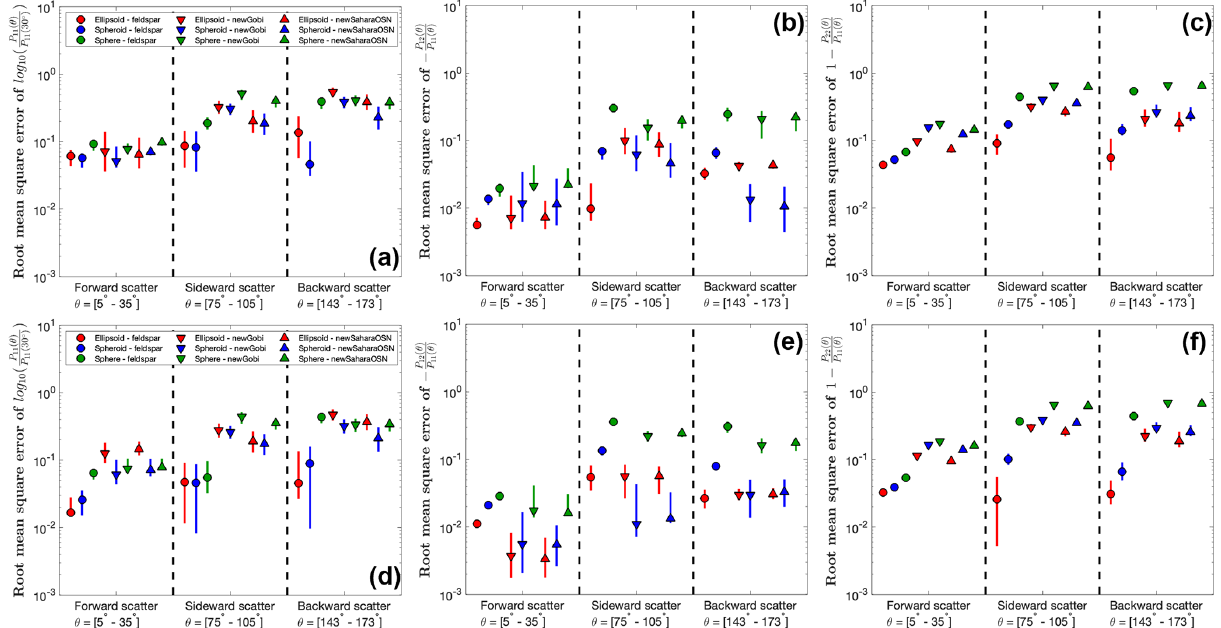
Figure 6. Root mean square errors (RMSEs) between the laboratory-measured and simulated scattering matrices at forward-, side-, and backscattering angles. The top column shows RMSEs at the smaller visible wavelength, which is 441.6nm for AGLSD mineral sample feldspar and 488.0nm for the other two dust samples (i.e., newGobi and newSaharaOSN). The bottom column shows RMSEs at the larger visible wavelength, which is 632.8nm for feldspar and 647.0nm for newGobi and newSaharaOSN. The vertical error bars denote uncertain- ties from the dust refractive index and dust shape distributions (see Sect. 2.2 and